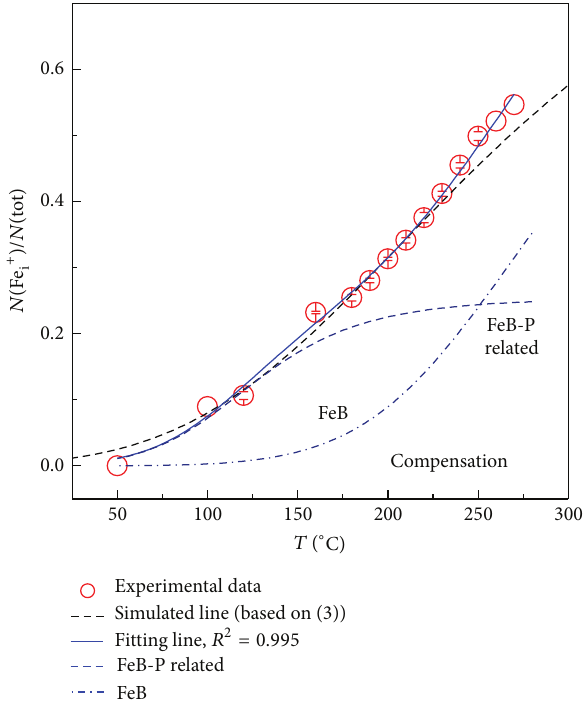
Figure 4: The ratio of N (Fe i + )/ N (tot) as a function of temperature for CZ-2. Red circles refer to the experimental data, and the black dash line is a simulated line based on the function of N (Fe i + )/ N (tot) = 1/(1 + 4 × 10 −3 exp (0.25 eV /𝜅 B 𝑇) ). The blue solid line represents a best fit which can be separated by the dark blue short dash dot line based on the function of 0.74/(1 + 2.6 × 10 −5 exp (0.53 eV /𝜅 B 𝑇) ) for FeB and the dark blue short dash line based on the function of 0.16/(1 + 2 × 10 −6 exp (0.45 eV /𝜅 B 𝑇) ) for